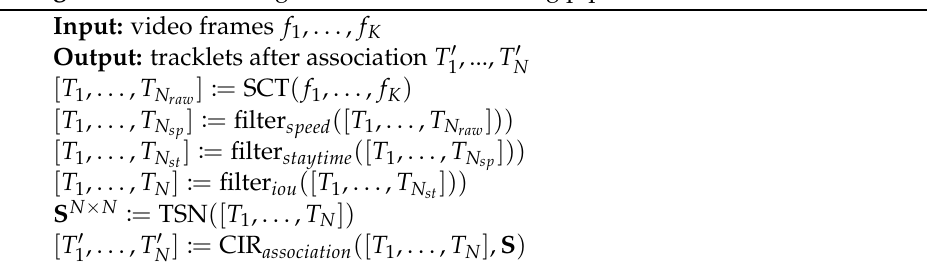
Algorithm 2: Multi-target multi-camera tracking